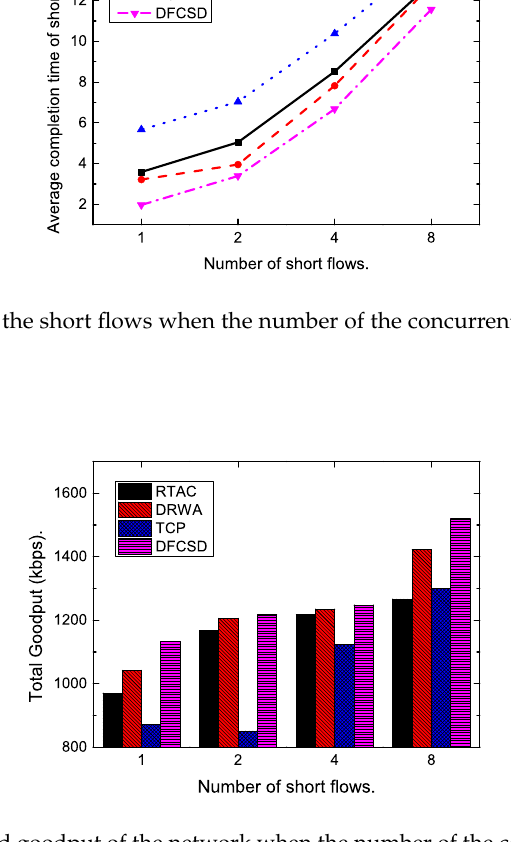
Figure 14. The obtained goodput of the network when the number of the competing short flow varies from 2 to